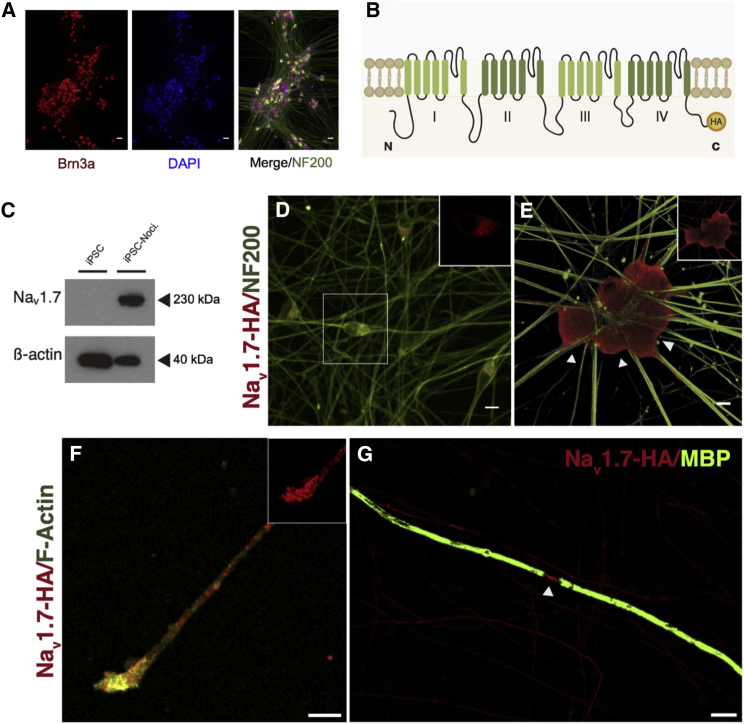
Genome Tagging of NaV1.7 Identifies Precise Subcellular Localization(A) Representative split channel image of iPSC nociceptors following differentiation, Brn3a (sensory marker, red), DAPI (nuclei, blue), and NF200 (neurofilament, green).(B) NaV1.7 membrane topology, the location of the C-terminal HA epitope tag is indicated in yellow.(C) Representative immunoblot of NaV1.7 protein expression in SCN9A-HA iPSC and 60 DIV SCN9A-HA iPSC nociceptors; loading control β-actin.(D and E) Immunocytological co-staining of 25 DIV (D) and 60 DIV (E) iPSC nociceptors, NF200 (green), NaV1.7-HA (red), inset image depicts separated channel NaV1.7-HA stain. Arrows in (E) indicate marked cell surface expression.(F) Representative image showing NaV1.7 expression in the axonal terminals of mature cultures, F-Actin (green), NaV1.7-HA (red), inset; separated channel image of NaV1.7-HA stain.(G) NaV1.7 localized to the node of Ranvier (arrow) in a myelinated co-culture, myelin basic protein (green), NaV1.7-HA (red).Scale bars, 25 μm (A) and 10 μm (D–G). See also Figures S3 and S4.